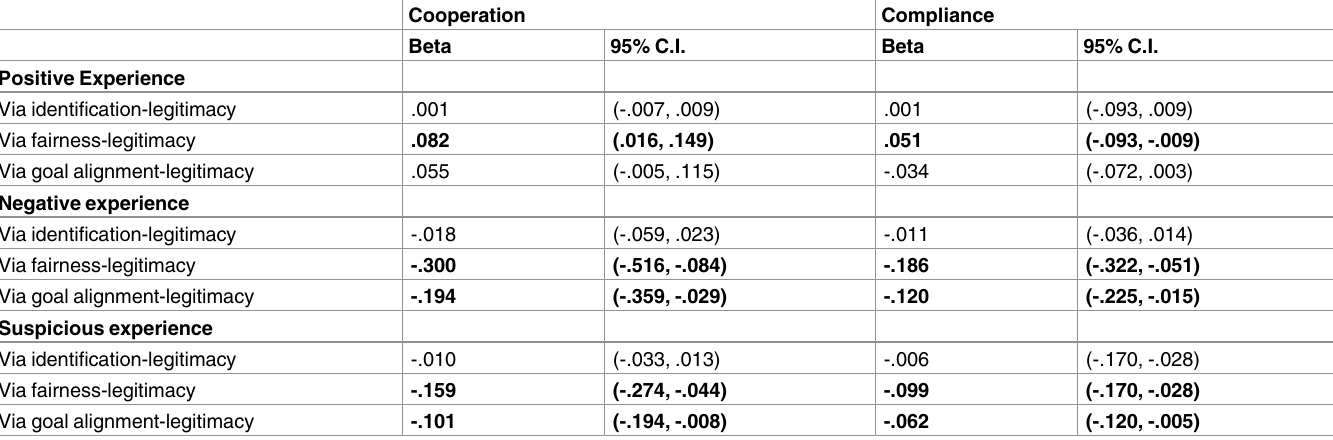
Table 4. Indirect paths from three types of experiencewith the police to cooperation and